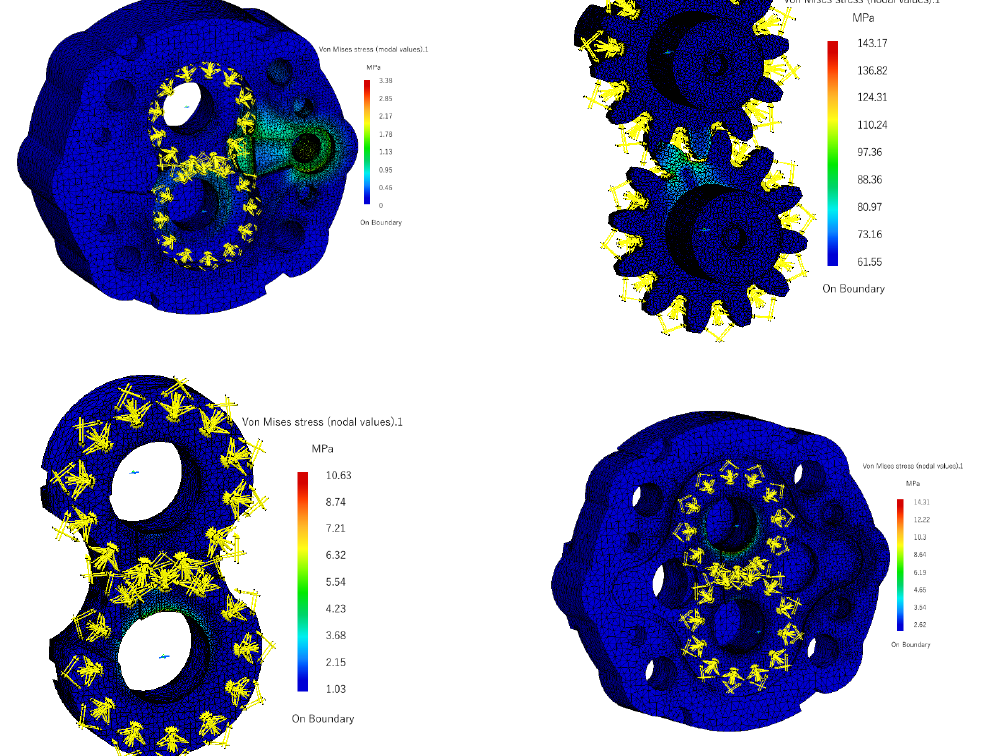
Figure 12. Mesh representations of the main pump components for the third parametric variant .